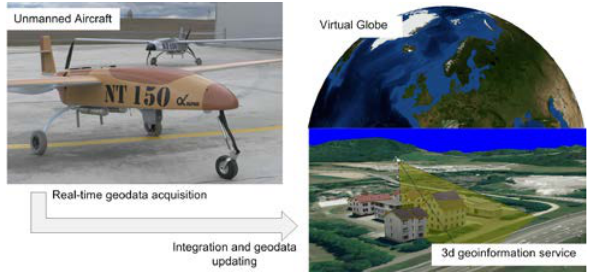
Figure 1: Goal of the UAVision project: integration of UAV mission management and UAV based geodata into a virtual globe environment. UAV NT150 (left) – i3D OpenWebGlobe